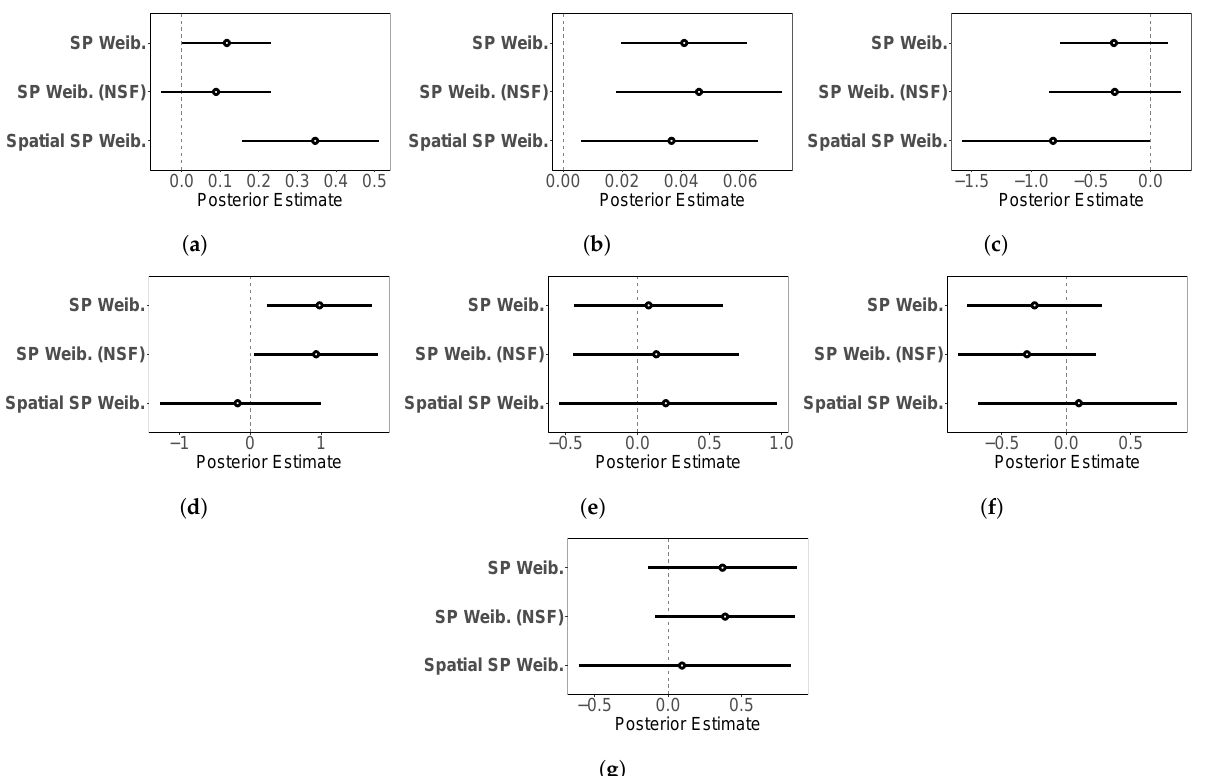
Figure 6. Democratic survival stage ( ˆ β ) coefficient results from SP Weibull, NS Frailty SP Weibull, and Spatial SP Weibull models for the following covariates: ( a ) GDP/cap, ( b ) GDP growth, ( c ) mil- itary government, ( d ) monarchy, ( e ) civilian government, ( f ) parliamentary government, and ( g ) presidential